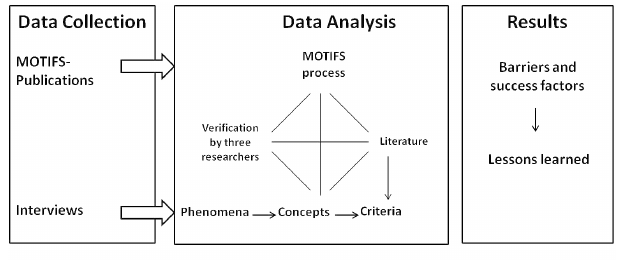
Fig. 2 . Methodology for reflection on the MOTIFS development